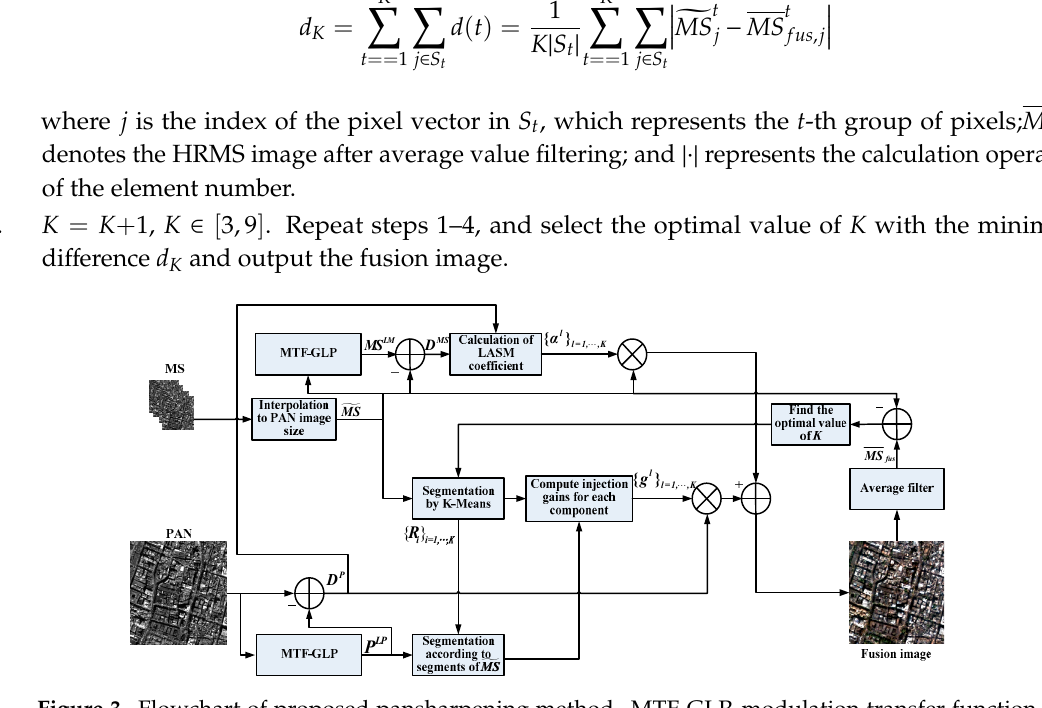
Algorithm 2 Pansharpening algorithm based on cooperation with